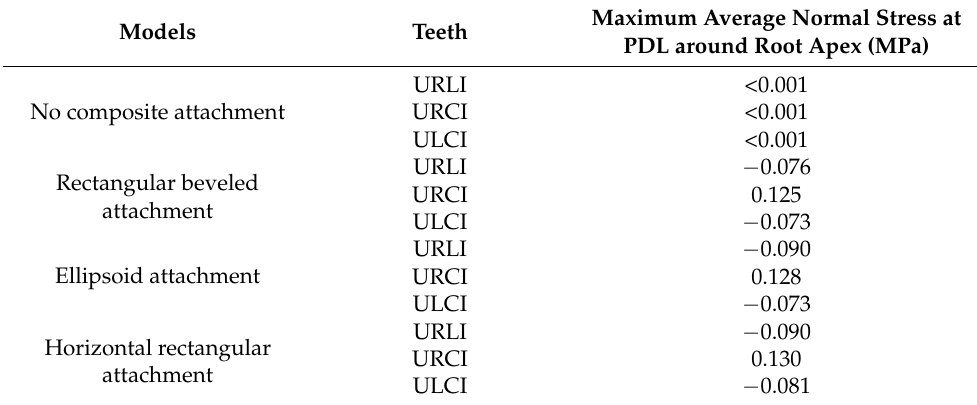
Table 3. Maximum of average normal stress at PDL around root apex: tensile stress as positive (+) values and compressive stress as negative ( − ) values.